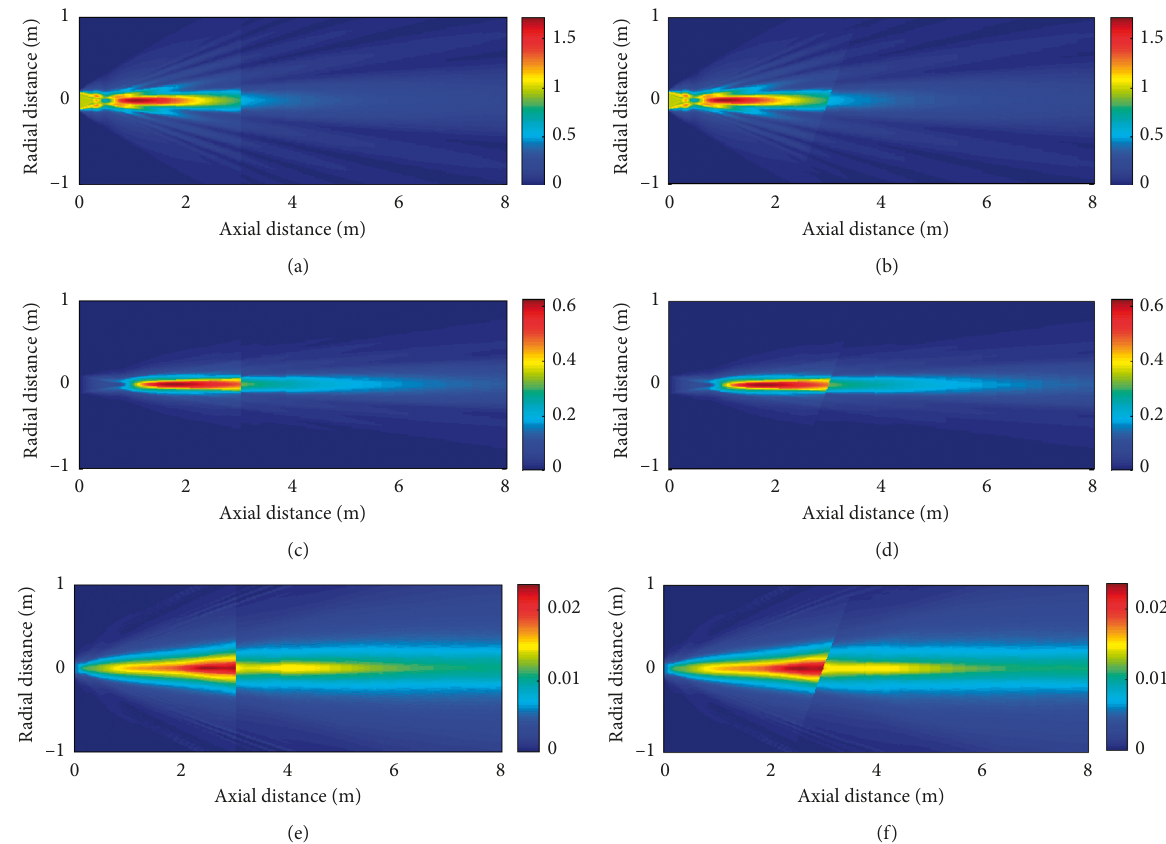
Figure 3: Simulated sound pressure distribution with the different angle incident water-aluminum boundary models. (a) f � 95kHz, θ � 0 ∘ ; (b) f � 95kHz, θ � 30 ∘ ; (c) f � 205kHz, θ � 0 ∘ ; (d) f � 205kHz, θ � 30 ∘ ; (e) f � 15kHz, θ � 0 ∘ ; (f) f � 15kHz, θ � 30 ∘ .